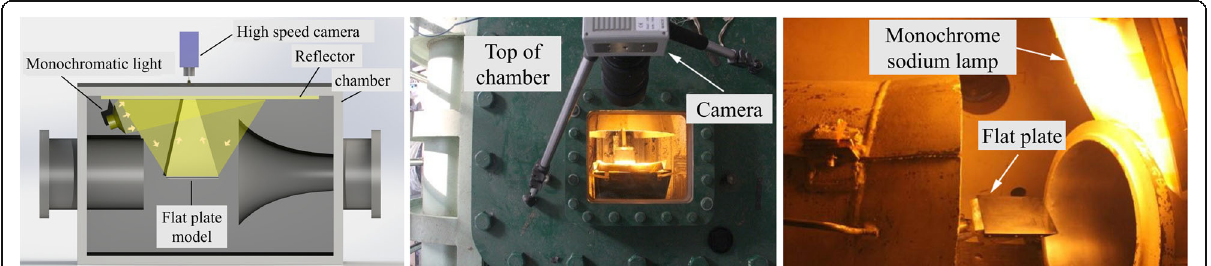
Fig. 7 Optical path design of oil-film interferometry experiment in